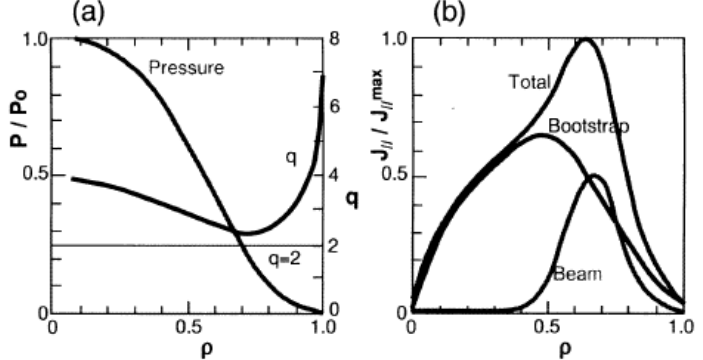
Figure 16. Negative shear operation scenario using off-axis current drive by Ozeki [92].